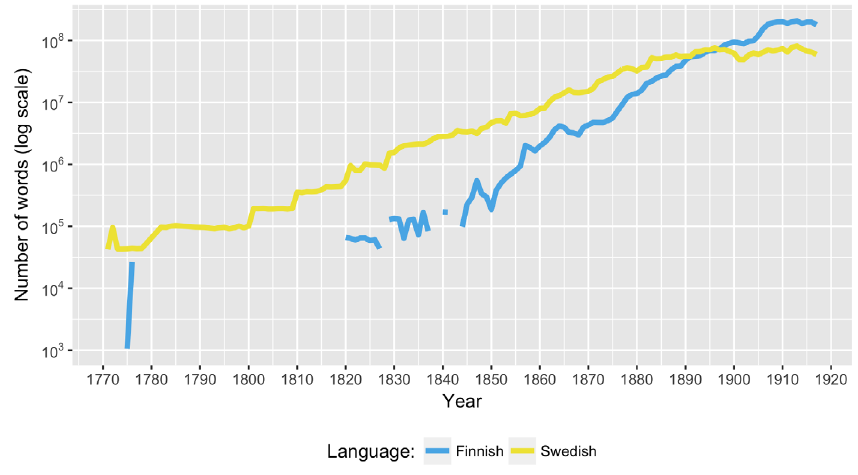
Fig. 2 Words published in Finnish-language and Swedish-language newspapers in Finland,